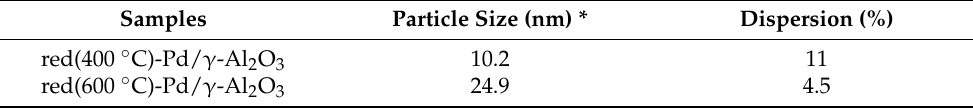
Table 2. Palladium particle sizes estimated from CO